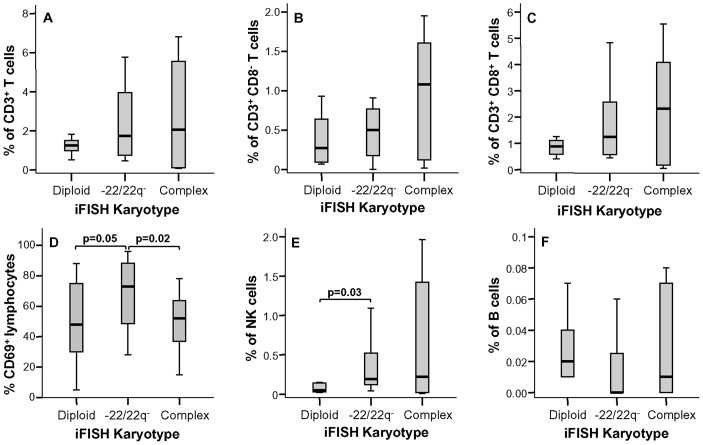
Distribution of the major lymphocyte subsets and activated CD69+ lymphocytes in inflammatory infiltrates of meningiomas classified according to the cytogenetic profile of tumor cells.The percentage of total CD3+ T cells (panel A), CD3+ CD8− T cells (panel B), CD3+ CD8+ T cells (panel C), activated CD69+ lymphocytes (panel D), CD3− CD19− 56+ NK cells (panel E) and CD3− CD19+ B cells (panel F) are shown. Notched-boxes represent 25th and 75th percentile values; the lines in the middle and vertical lines correspond to median values and the 10th and 90th percentiles, respectively.